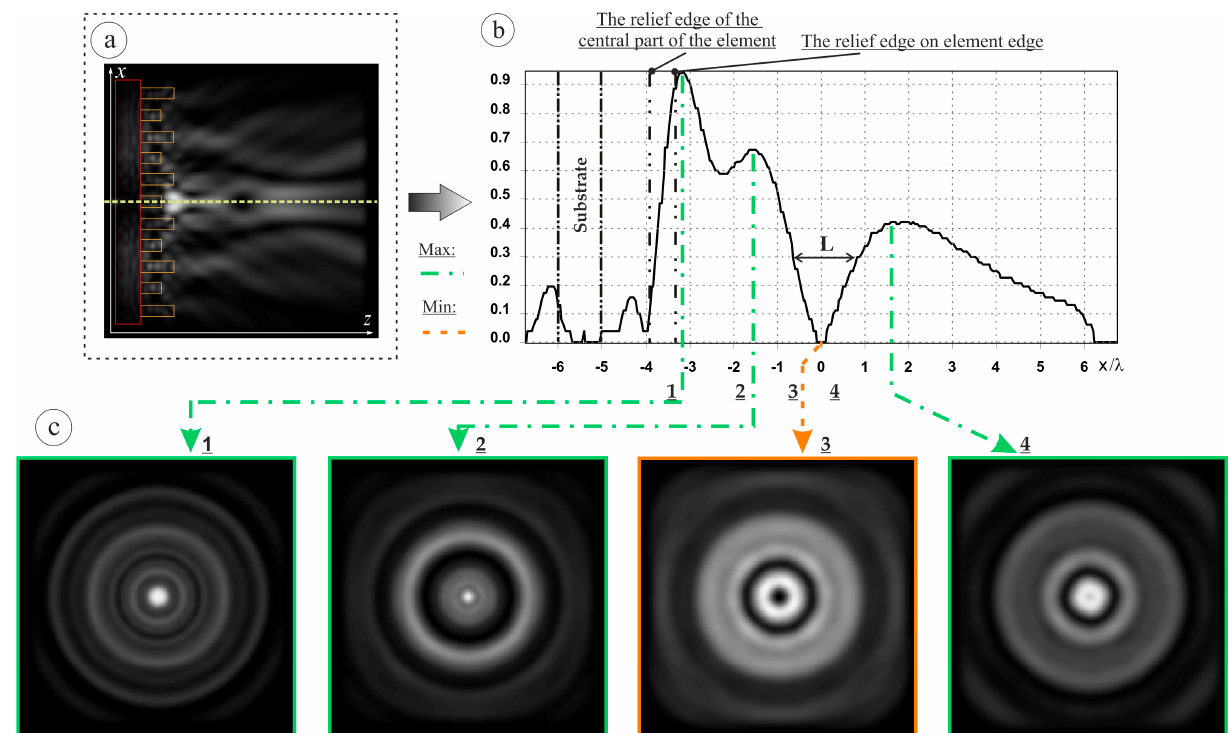
Figure 8. Two-dimensional diffraction pattern of the Laguerre–Gaussian mode (1,0) (see Figure 7 a ): ( a ) xz plane, ( b ) cross section in the xz plane, and ( c ) cross sections in the xy plane.